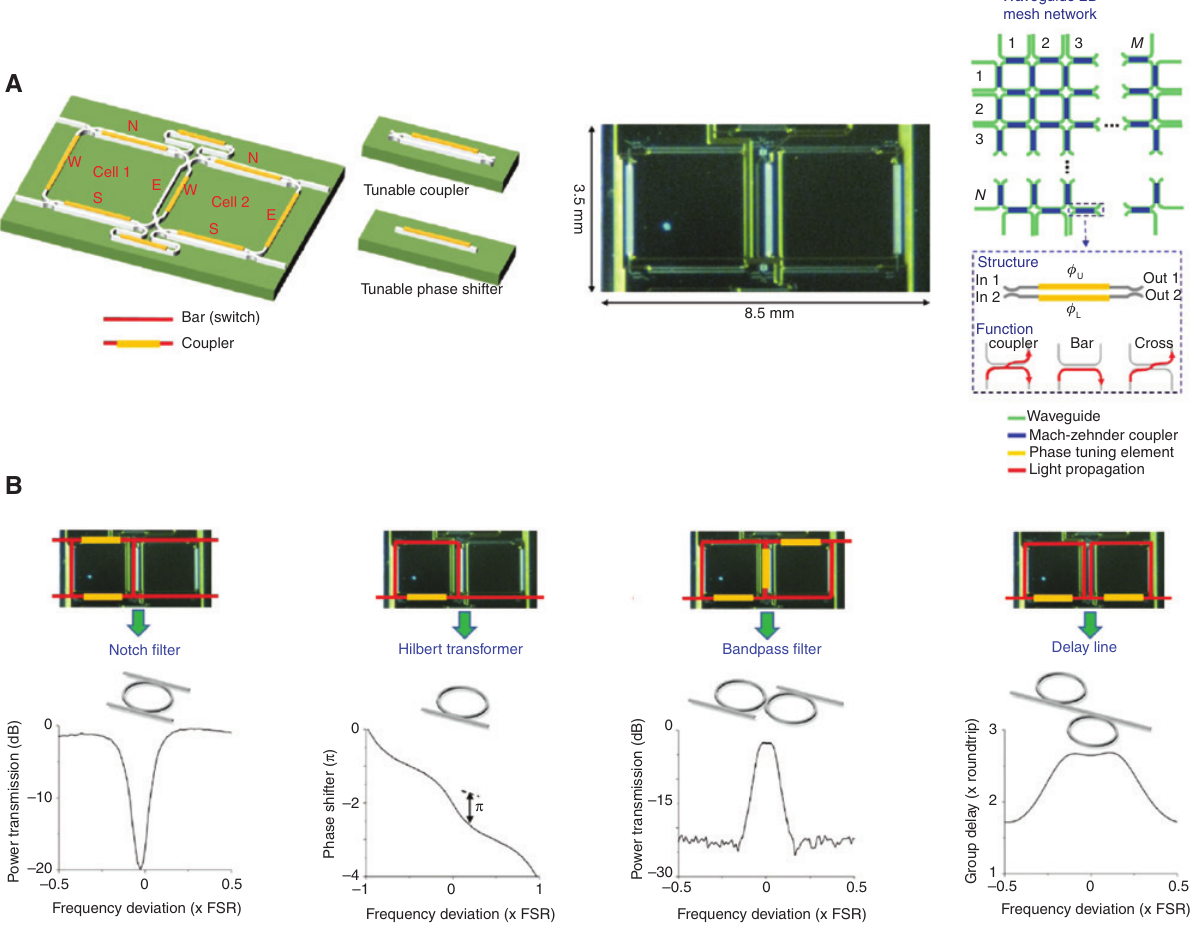
Figure 10: Programming and different circuit emulations using a two-cell square waveguide mesh in silicon nitride. (A) Schematic and a photo of the Si N waveguide technology (TriPleX) chip implementing a 2-square cell waveguide mesh reported in 3 4 Ref. [9]. (B) Experimental results for different programmed circuit configurations obtained by varying phase-tuning elements in the chip and the measurements of their corresponding frequency